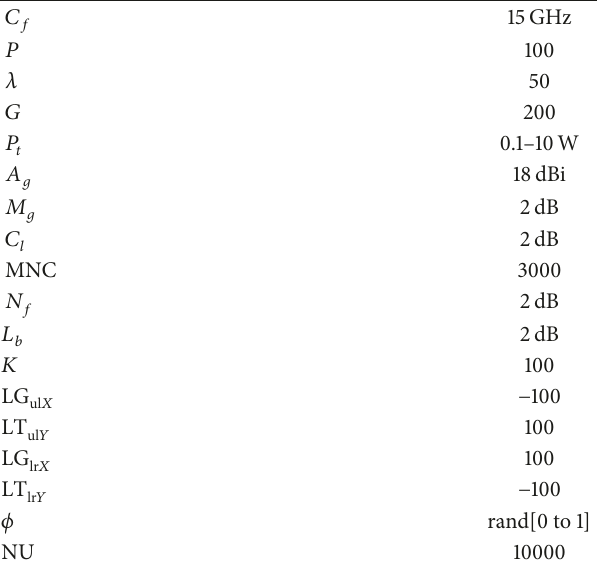
Table 1: Simulation